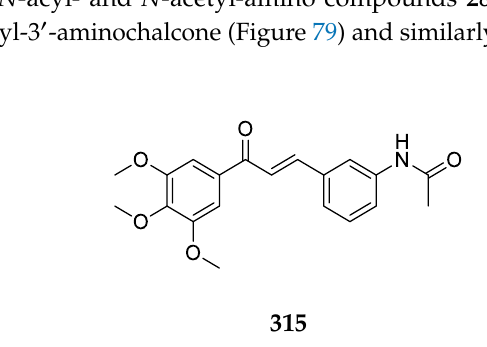
Figure 79. Chemical structure of N -actyl-3′-aminochalcone derivatives with substitution on ring A.